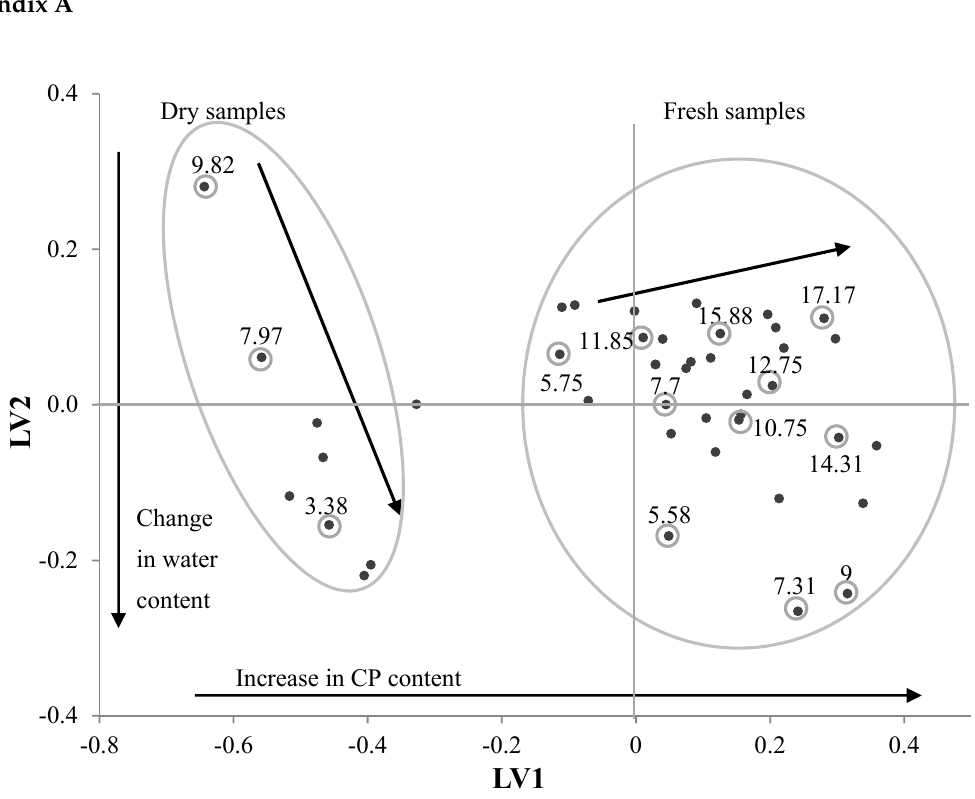
Figure A1. Score plot for the partial least-squares (PLS) model for crude protein (CP). Numbers next to the gray circles represent the CP% values (reference). The first LV component reflects the quantitative change in CP content, as measured in the samples, whereas the second LV component exhibits changes in water content, which impact on the spectral reflectances of all surfaces. The CP content increases from left to right along the axes and water content increases from top to bottom.